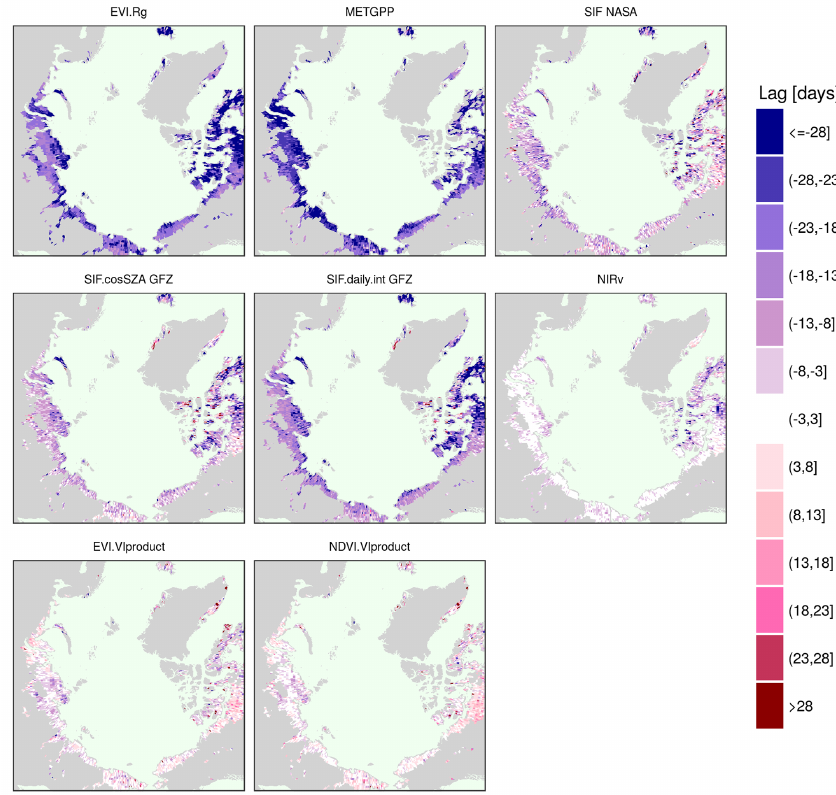
Figure A5. Average time difference of the maximum across years of selected vegetation proxies and the NDVI.